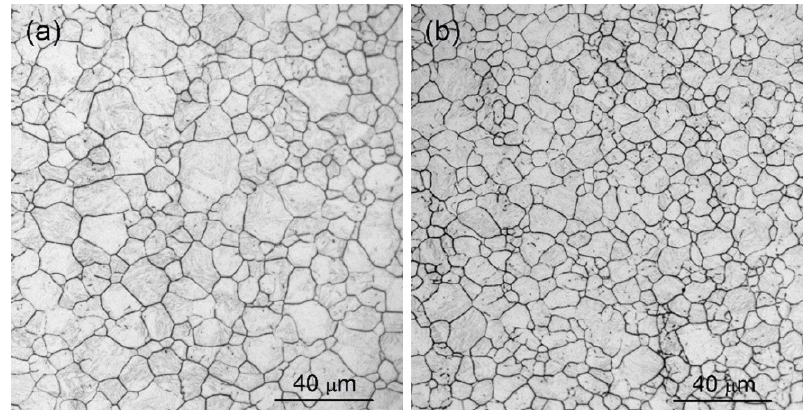
Figure 1. Optical morphologies of prior austenite grains of ( a ) TB0 and ( b ) TB1 steels after quenching.